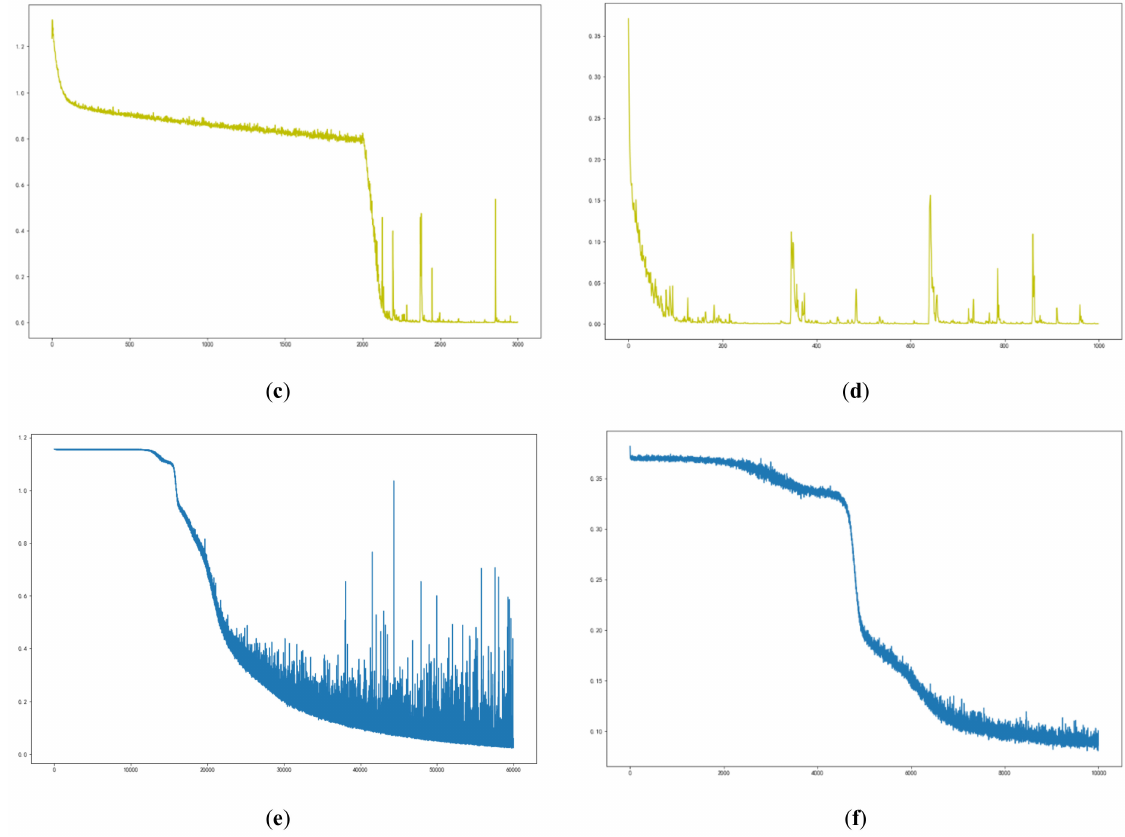
Figure 9. Loss of directly collected signal classification during neural network training: ( a ) WideResnet40_2 octonary classification, ( b ) WideResnet40_2 binary classification, ( c ) Densenet121 octonary classification, ( d ) Densenet121 binary classification, ( e ) LSTM octonary classification, and ( f ) LSTM binary